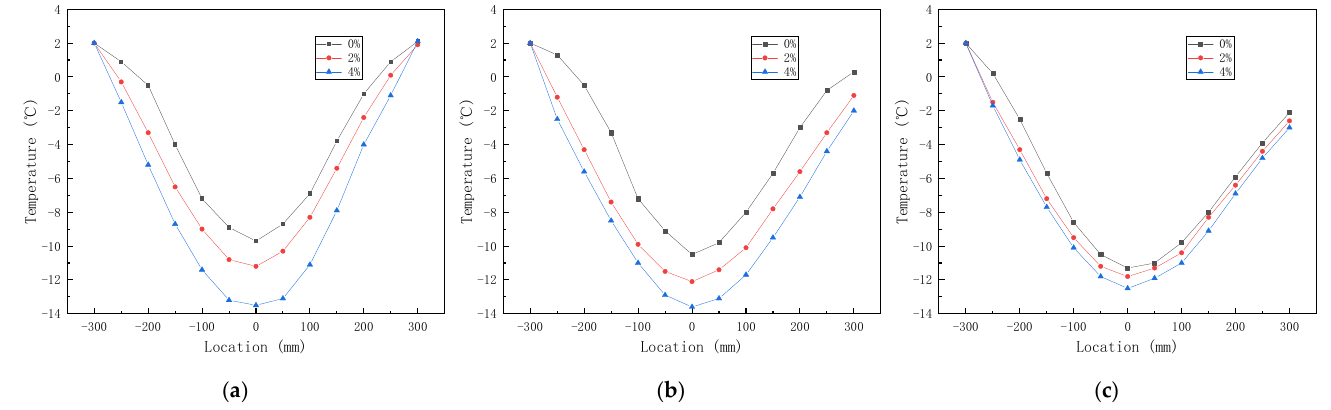
Figure 10. The temperature distribution on the interface C-axis at ( a ) 0 m/d; ( b ) 3 m/d; ( c ) 6 m/d. 4.2. The Overlapping Times of the Frozen Curtain under Different Velocities and Salinities Combined with the temperatures at all measuring points, the development of the frozen curtain can be determined. According to the above research on the saline sand, the freezing temperature of the saline sand was determined. From the above analysis, the freezing temperatures measured for salinities of 0%, 2%, and 4% were −0.1, −1.4, and −3.1 °C, respectively. The temperatures were used as the boundary basis for the frozen curtain. Then the overlapping time of the double-pipe frozen curtain could be obtained. Figure 11 shows the overlapping times under three velocities and three salinities. The existence of salt changed the thermodynamic characteristics of the salinity sand, resulting in the change of overlapping time. In addition, the velocity would also prolong the overlapping time of the frozen curtain. Under the three salinities, the overlapping times increased with the increase in the velocity. But the relationship between the two was nonlinear. Taking 0% salinity as an example, when the velocity increased from 0 m/d to 3 m/d, the overlapping time increased by 24%. When the velocity increased from 3 m/d to 6 m/d, the overlapping time increased by 60%. The overlapping time increased significantly when the velocity was 6 m/d. The relationship between the salinity and overlapping time can be described by a linear function. The slopes of the linear functions under three velocities were 0.88, 1.00 and 1.75, respectively. It showed that the larger the velocity, the greater the effect of the salinity on the overlapping time. Compared the effects of the velocity and salinity on the overlapping time, it is found that the velocity has a great effect on the overlapping time.